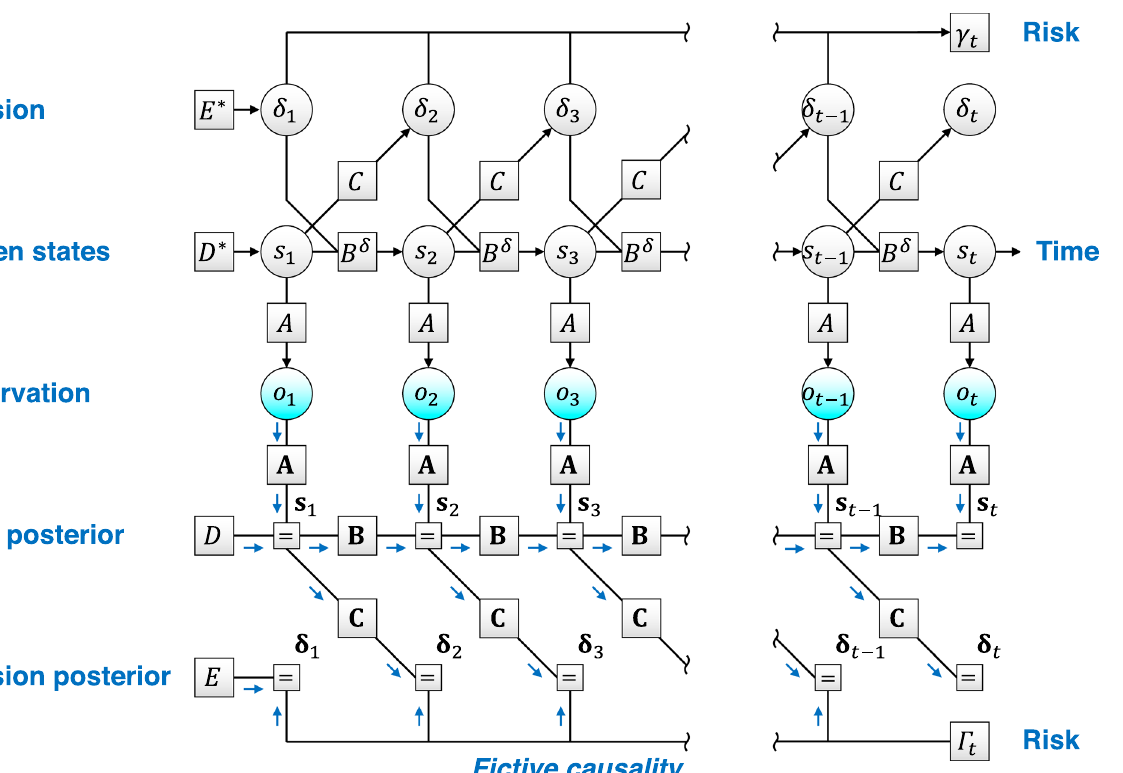
Fig. 2 Factor graph depicting a fi ctive causality of factors that the generative model hypothesises. The POMDP model is expressed as a Forney factor graph 69,70 based upon the formulation in ref. 71 . The arrows from the present risk γ t — sampled from Γ t — to past decisions δ τ optimise the policy in a post hoc manner, to minimise future risk. In reality, the current error γ t is determined based on past decisions (top). In contrast, decision making to minimise the future risk implies a fi ctive causality from γ t to δ τ (bottom). Inference and learning correspond to the inversion of this generative model. Postdiction of past decisions is formulated as the learning of the policy mapping, conditioned by γ t . Here, A , B and C indicate matrices of the conditional probability, and bold case variables are the corresponding posterior beliefs. Moreover, D (cid:6) and E (cid:6) indicate the true prior beliefs about hidden states and decisions, while D and E indicate the priors that the network operates under. When and only when D ¼ D (cid:6) and E ¼ E (cid:6) , inferences and behaviours are optimal for a given task or set of environmental contingencies, and are biased